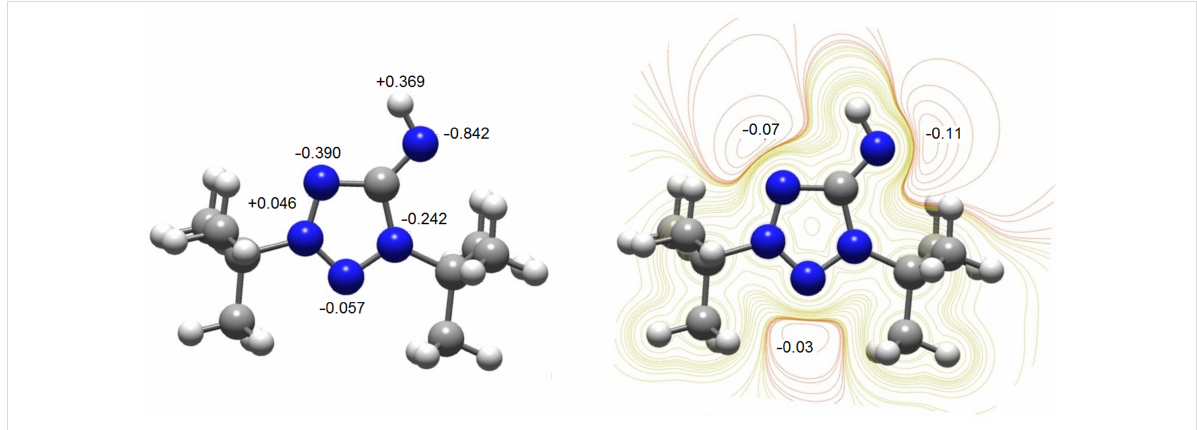
Figure 5: NPA charges (left) and MESP contour map (right) for the molecule of 8a .